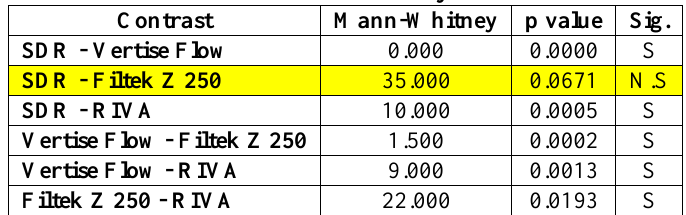
Table 4: Mann-Whitney U